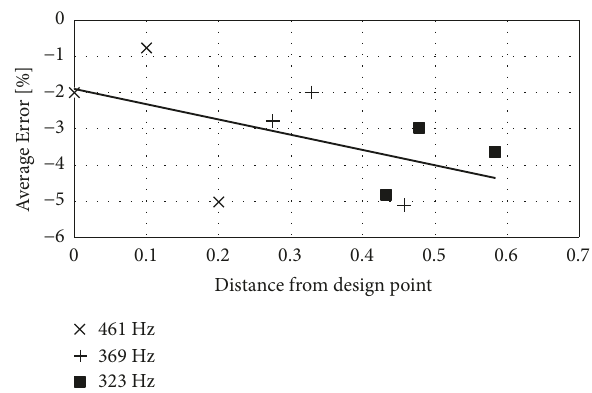
Figure 9: Variation in the average error for r/r 2 < 1.2 with the deviation from the design point.